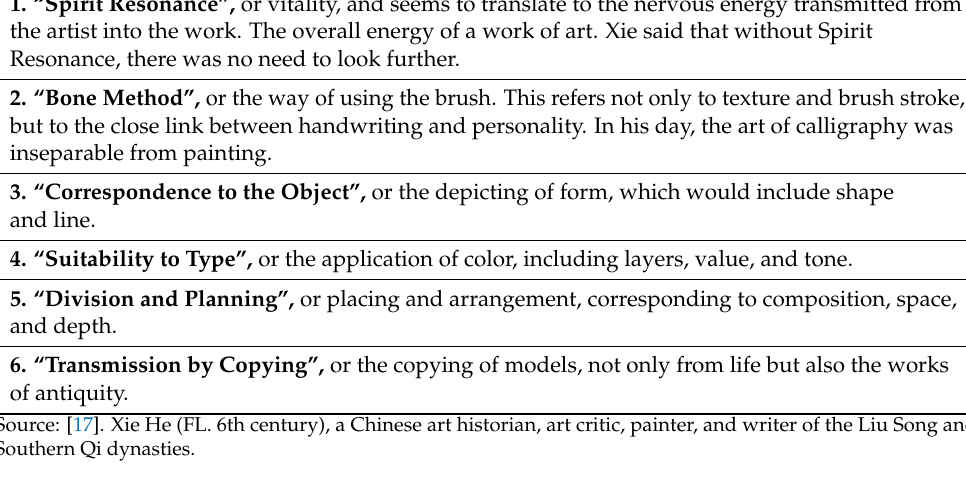
Table A2. The content of six principles of Chinese painting created by Xie